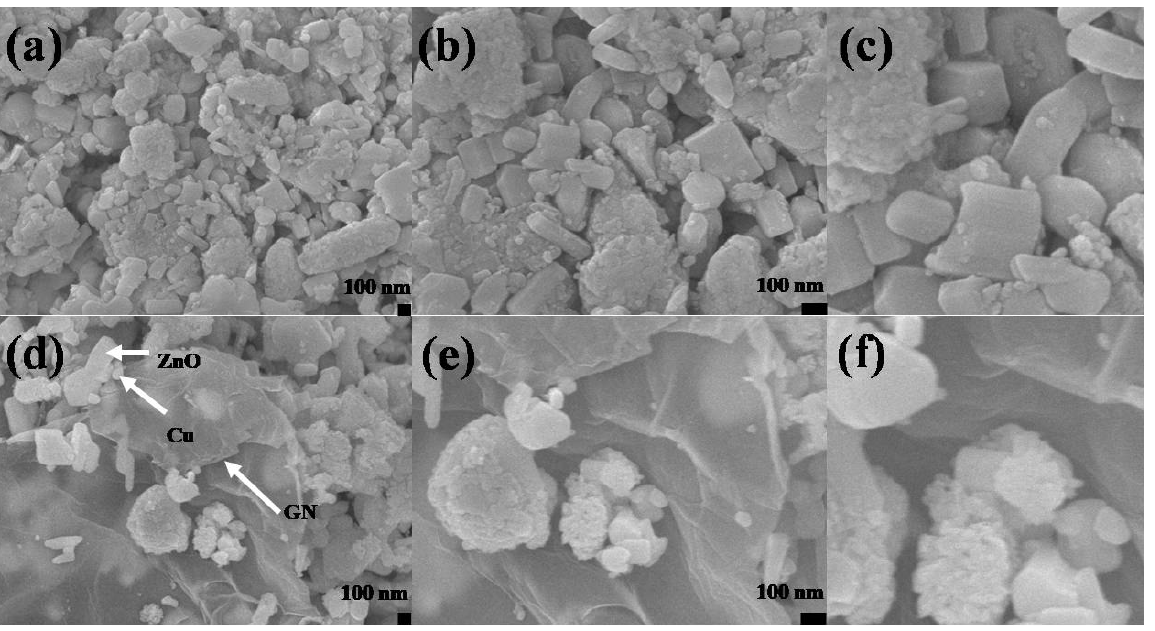
Figure 2. Scanning electron microscopy (SEM) images of ( a – c ) Cu–ZnO and ( d – f ) rGO@ZnO–Cu nanocomposites at different magnifications. ( a ), ( d ) at 30,000×, ( b ), ( e ) at 60,000×, and (c), ( f ) at 120,000×.